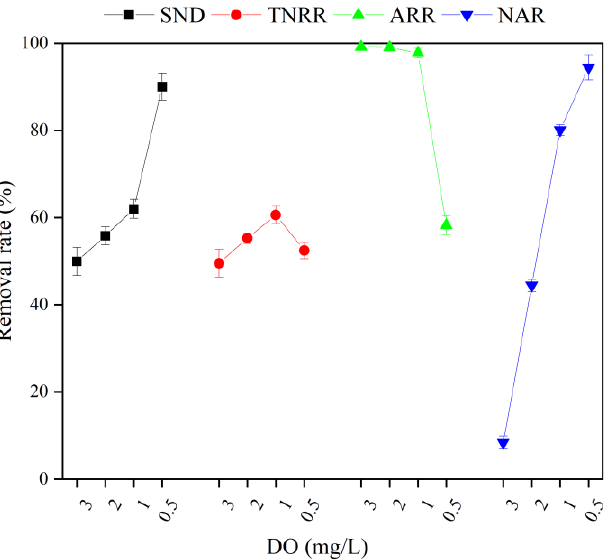
Figure 9. Performance of Shortcut SND with different DO levels in MBBR. Vertical bars represent ± SD of the means ( n = 3).